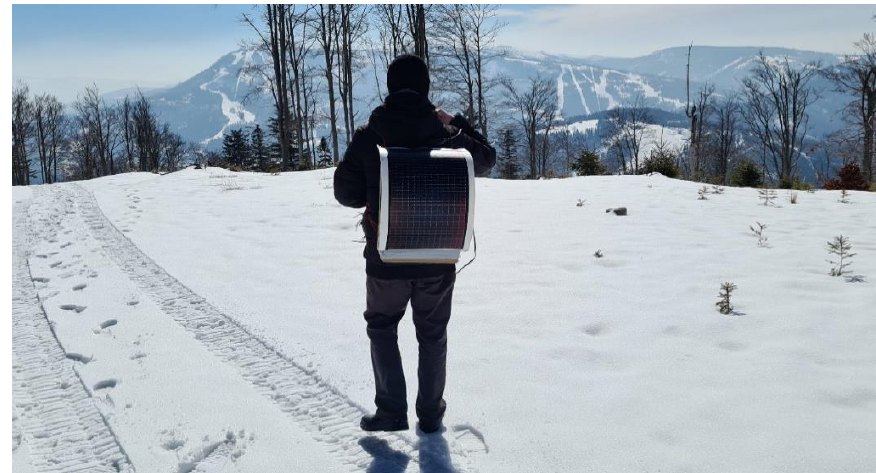
Figure 17. The flat rollable PV sheet during tests in real use conditions.